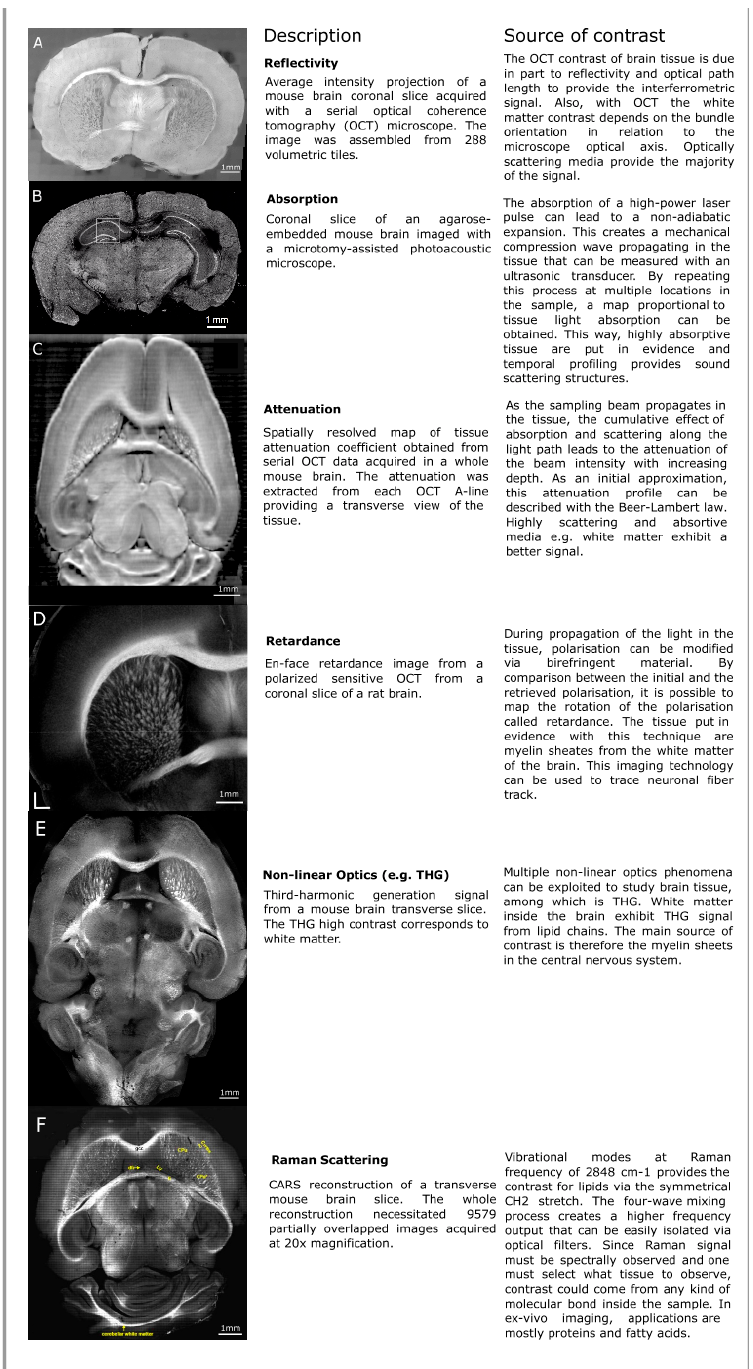
Figure 1. Examples of various intrinsic optical contrast mechanisms that can be used to image the brain: ( A ) Reflectivity, ( B ) absorption from photo-acoustics microscopy (PAM), ( C ) attenuation, ( D ) retardance from Optical Coherence Tomography (OCT) imaging, ( E ) nonlinear optics such as third-harmonic generation (THG), and ( F ) Raman scattering. The images for Figure 1A,C come from our previous work [16]. For more information about the images presented, consult the appropriate references. The absorption image is an excerpt from a still frame from the supplementary video 3 of Wong2017 [17], the THG image is a reproduction of Figure 3 from Farrar2011 [18], the retardance image comes from Wang2014 [19], and the Coherent Anti-stokes Raman Spectroscopy (CARS) image is taken from Fu2008